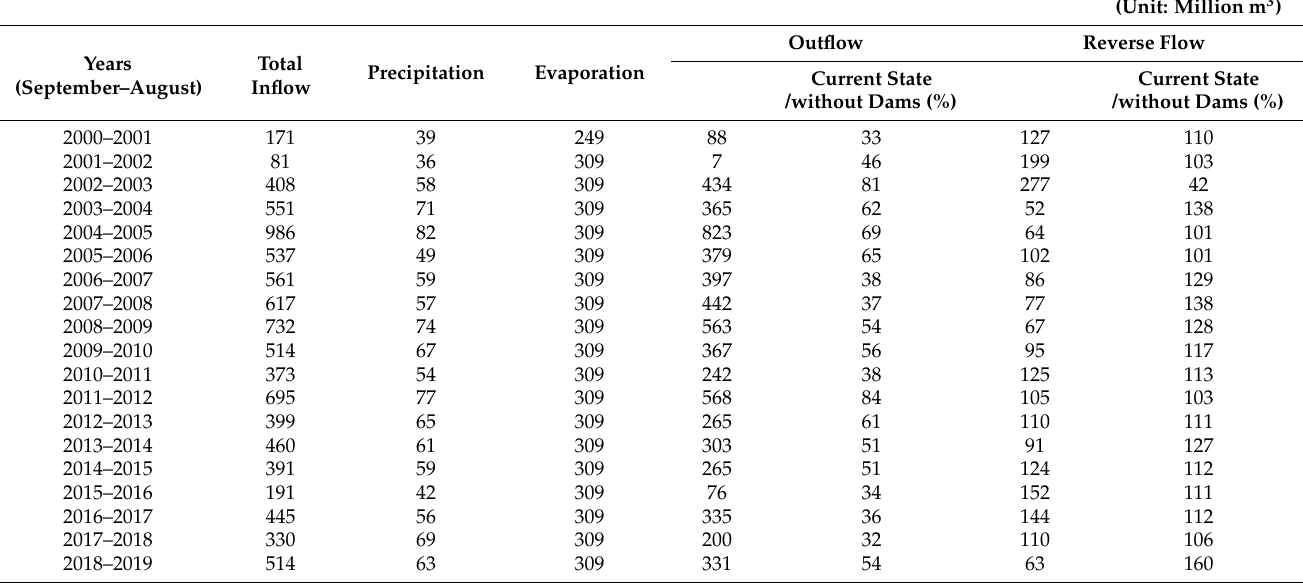
(Unit: Million m 3